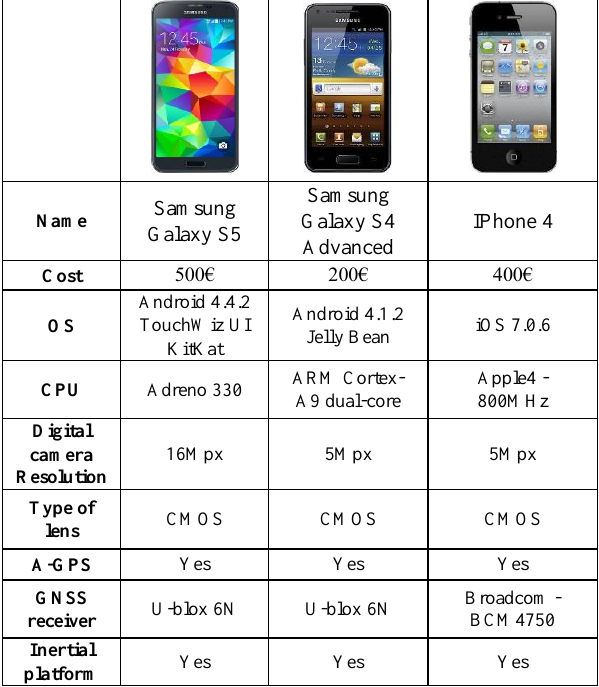
Table 1 - Devices and their principal characteristics